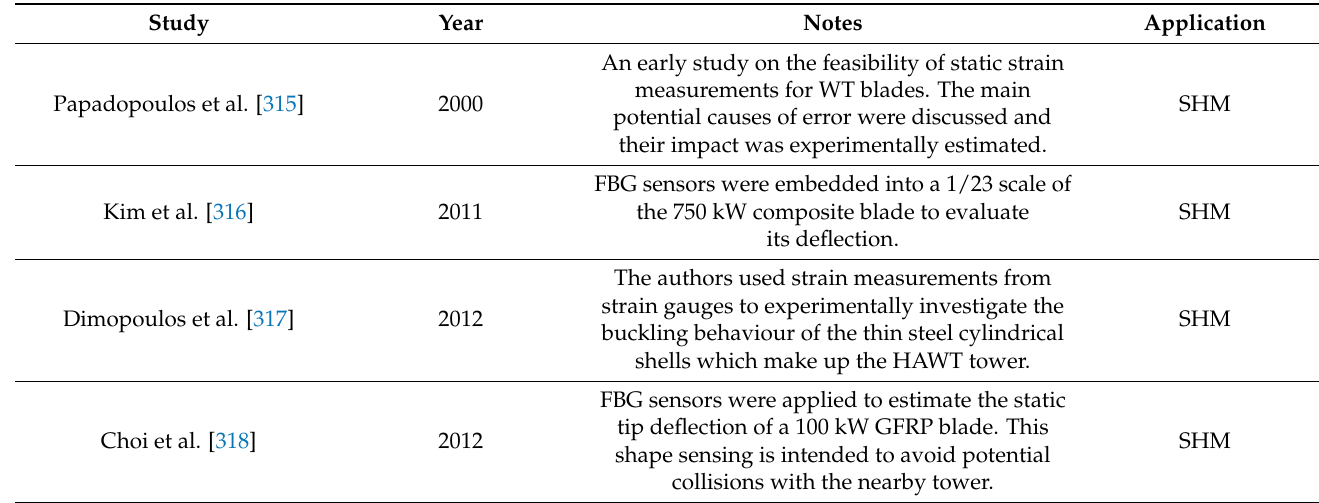
Table 11. Some notable and recent examples of strain measurements applications for wind